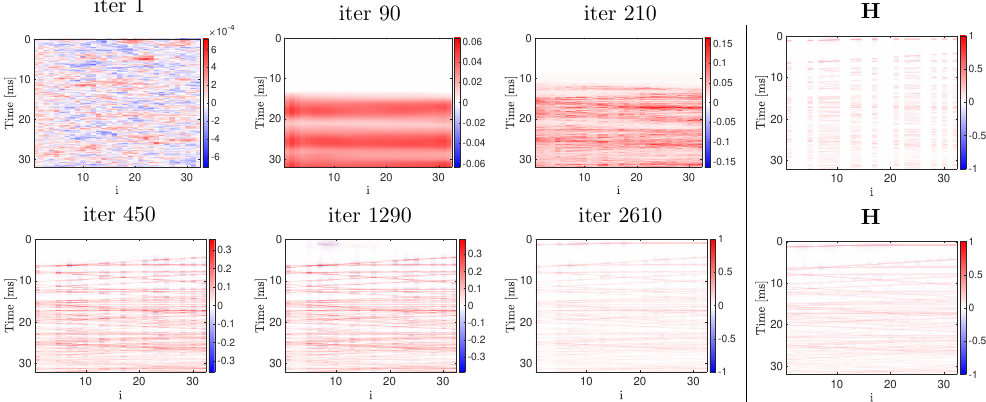
Figure 3. RIRs reconstruction procedure. The network output